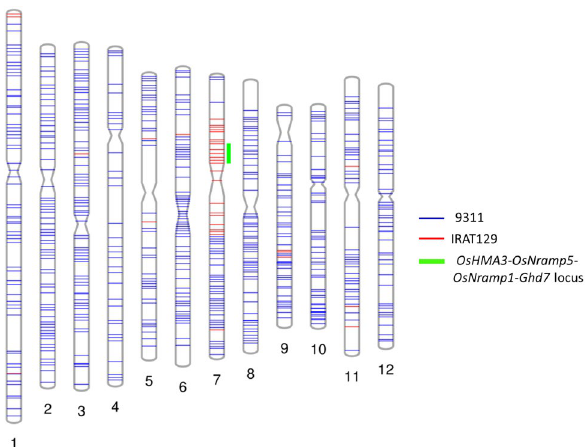
Figure 3. Graphical genotype maps of the improved 9311 (NIL9311-58). NIL9311-58 with the OsHMA3- OsNramp5-OsNramp1-Ghd7 jap haplotype was genotyped using 1.2 K SNP markers. Six hundred and thirty polymorphic SNPs between bi-parents were used for the construction of the genotype maps.